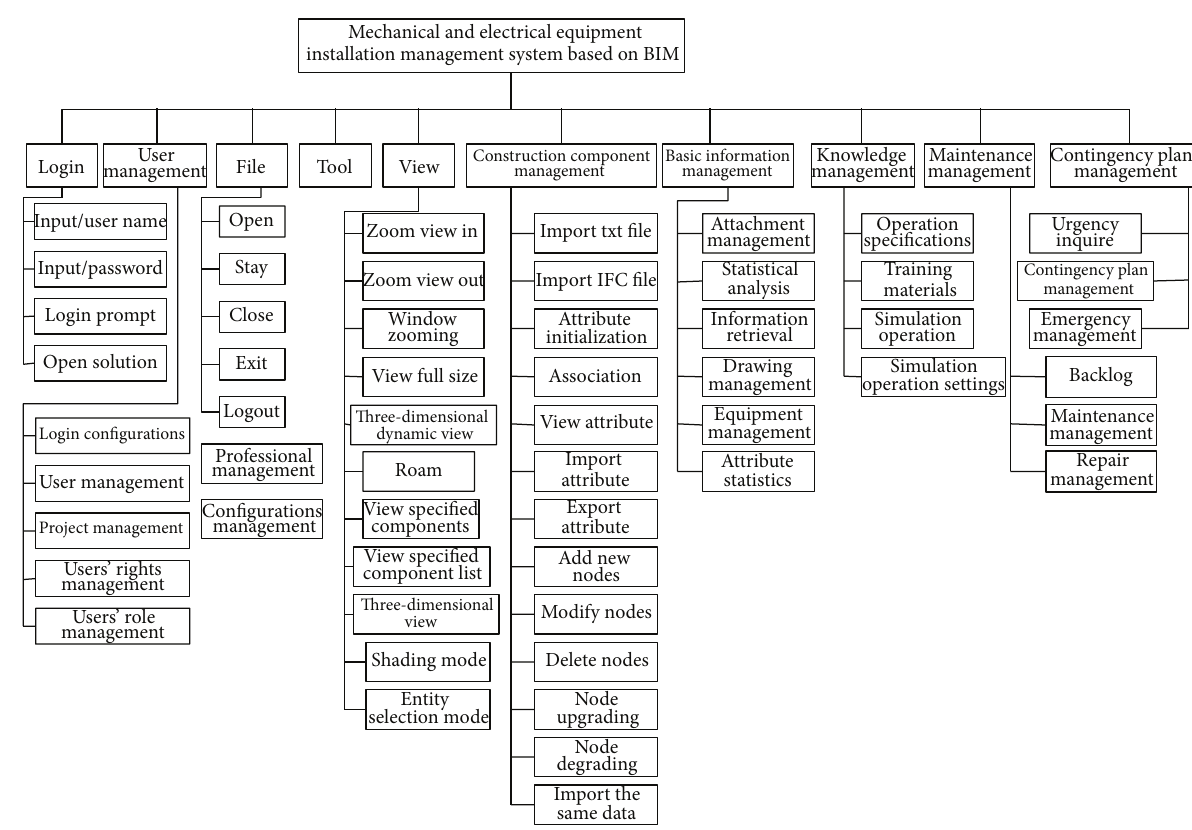
Figure 1: Mechanical and electrical equipment installation management system based on BIM.